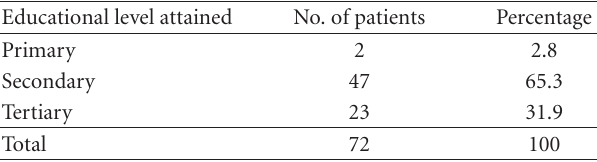
Table 3: Educational status of 72 cases of